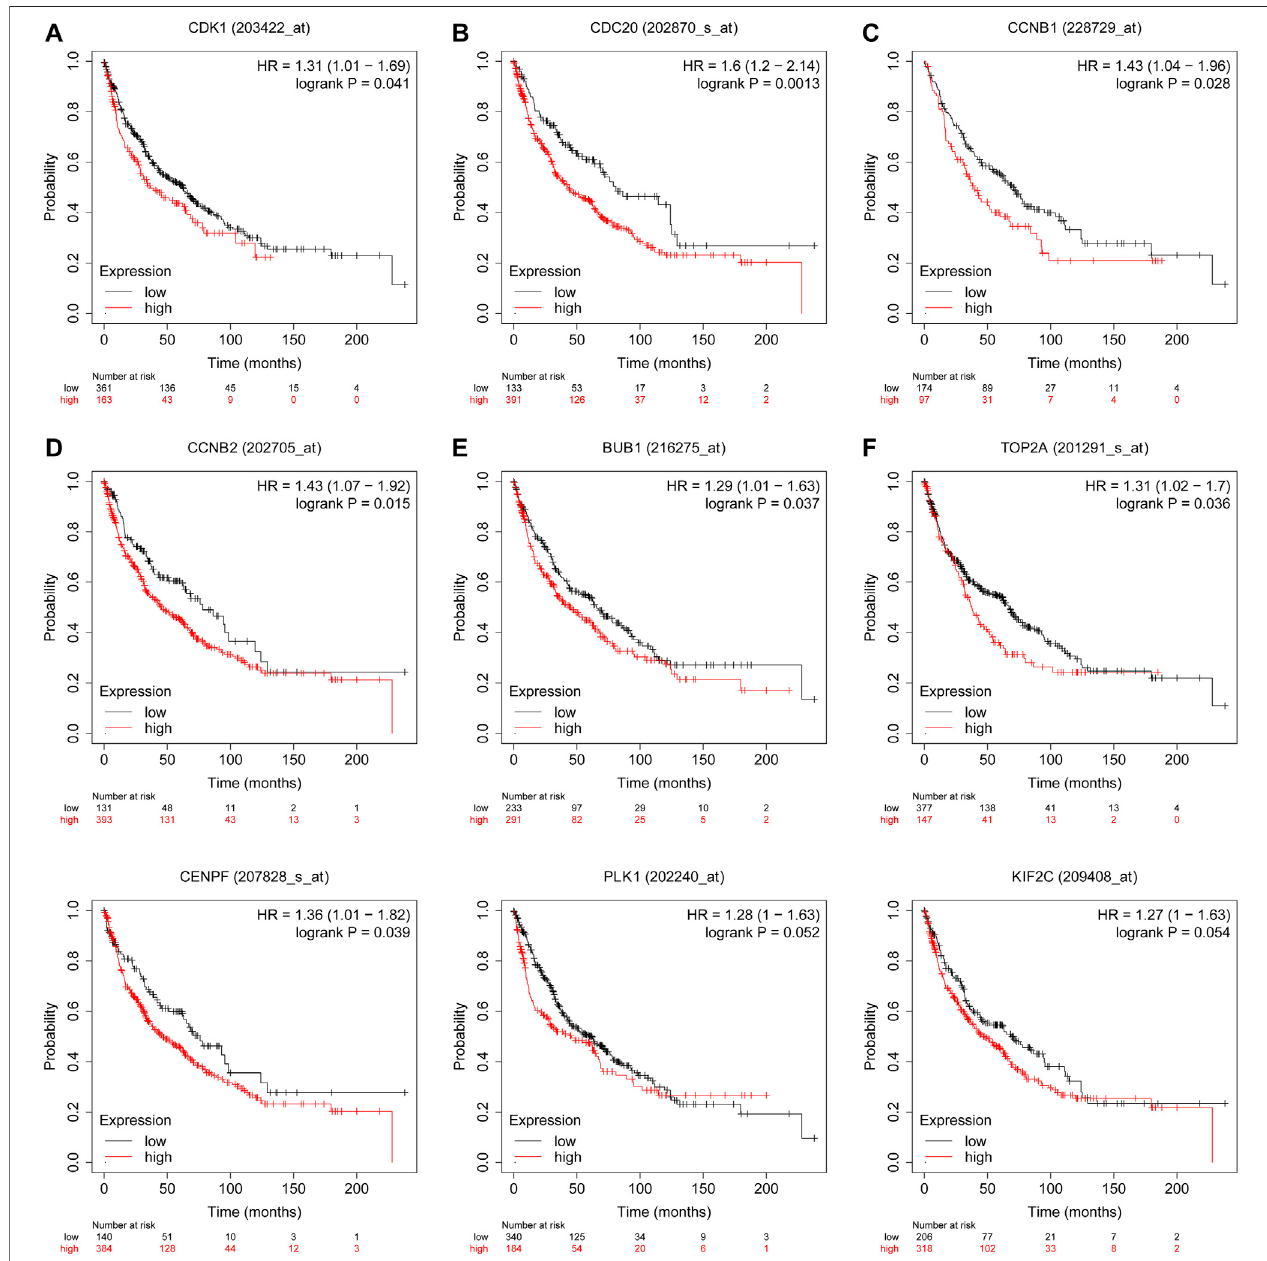
FIGURE 5 | Overall survival analyses of hub genes are performed in Kaplan-Meier plotter online platform. CDK1, CDC20, CCNB1, CCNB2, BUB1, TOP2A, and CENPF (A – G) arenegativelyassociatedwithOS.PrognosticvaluesofPLK1andKIF2C (H,I) areexploredinLUSCpatients. p < 0.05isconsideredstatisticallysigni fi cant.